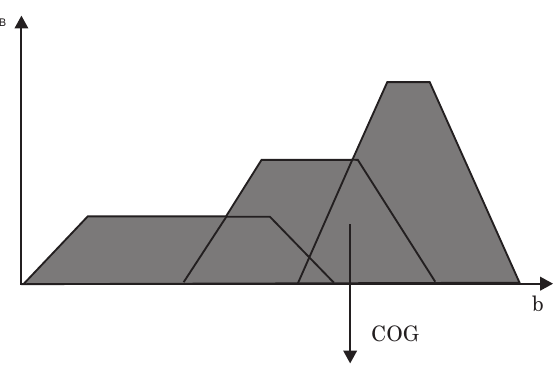
Figure 3. Defuzzification using the Center of Gravity (COG)